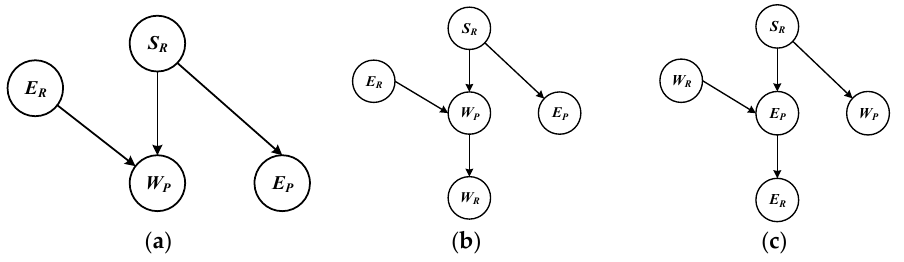
Figure 5. ( a ) The BN in first ‐ level planning; ( b ) The BN in second ‐ level planning; ( c ) The BN in third ‐ level planning. third-level